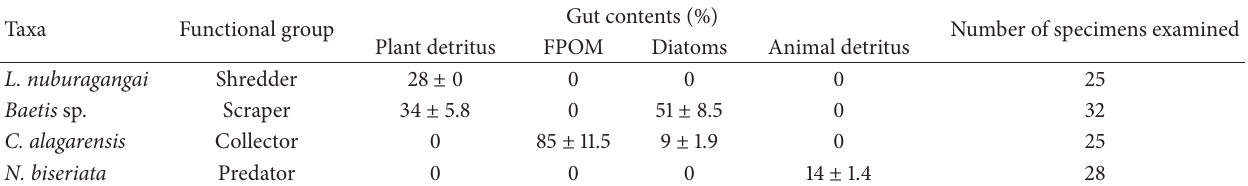
Table 3: The gut contents of functional feeding groups (mean ± SE).